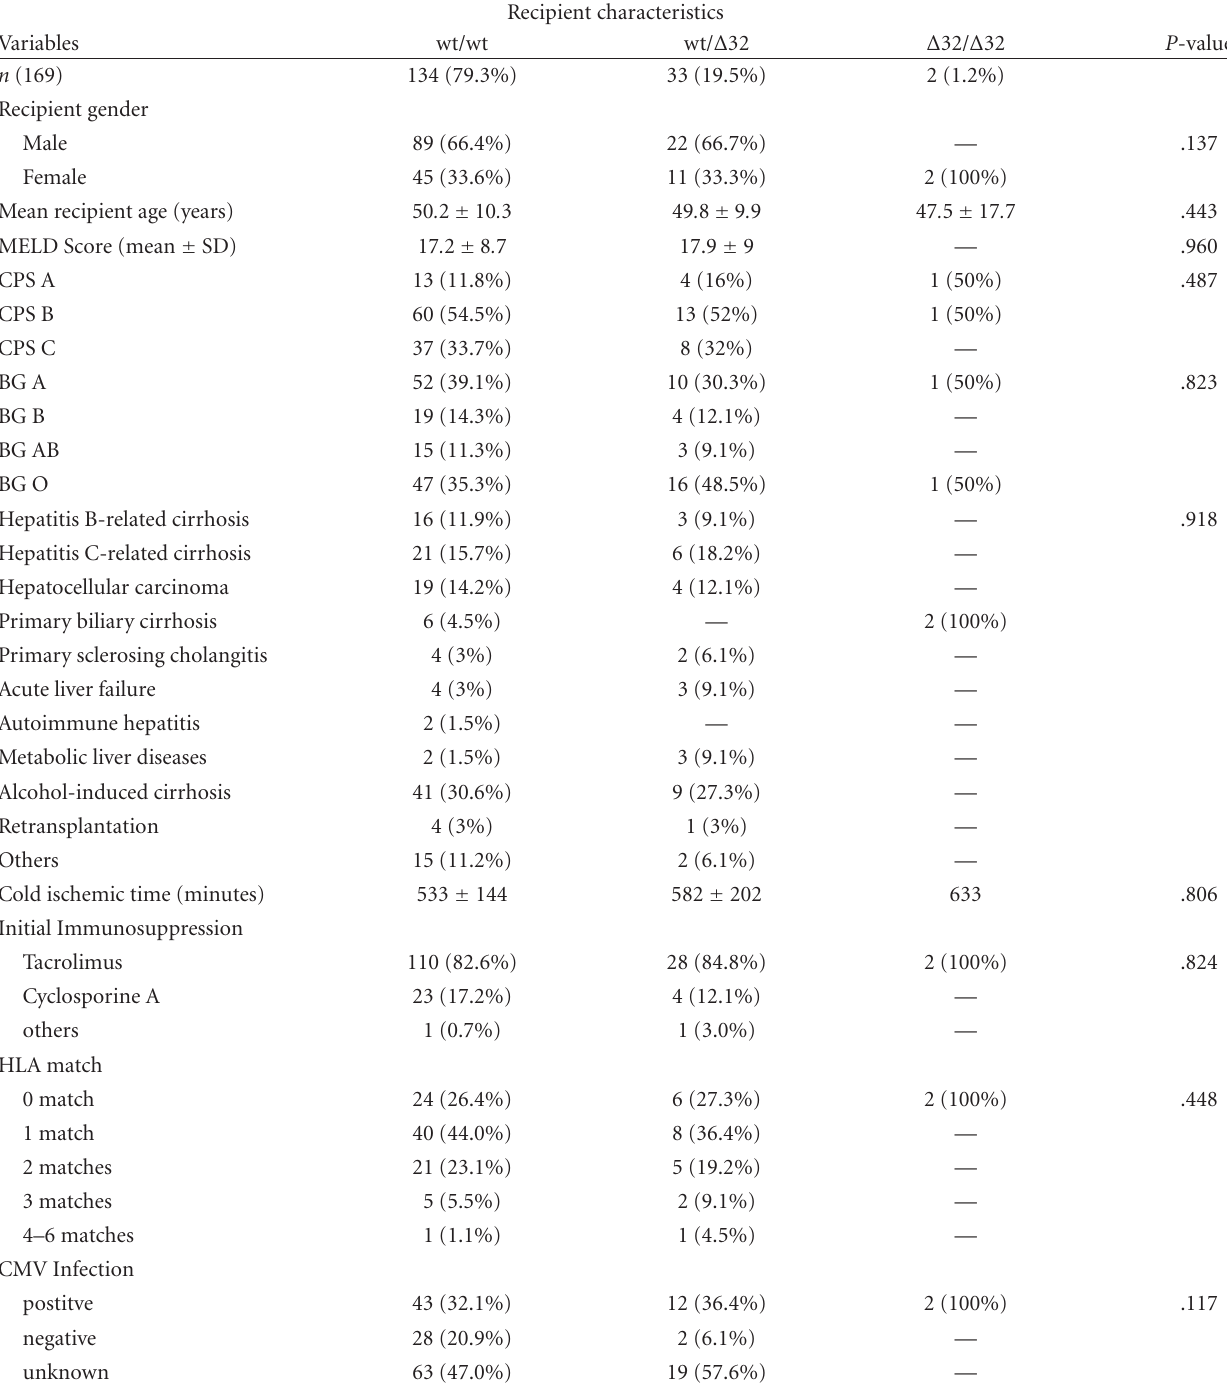
Table 1: Recipient characteristics. MELD: model for end-stage liver disease; CPS: Child-Pugh score; BG: recipients blood group; wt/wt: wild-type CCR-5; wt/ Δ 32: heterozygous CCR-5 Δ 32; Δ 32/ Δ 32: homozygous CCR-5 Δ 32; CMV: cytomegalovirus; OKT-3: monoclonal murine anti-CD-3